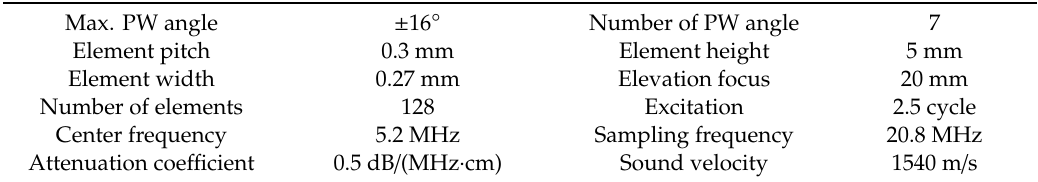
Table 1. Imaging parameters of PICMUS